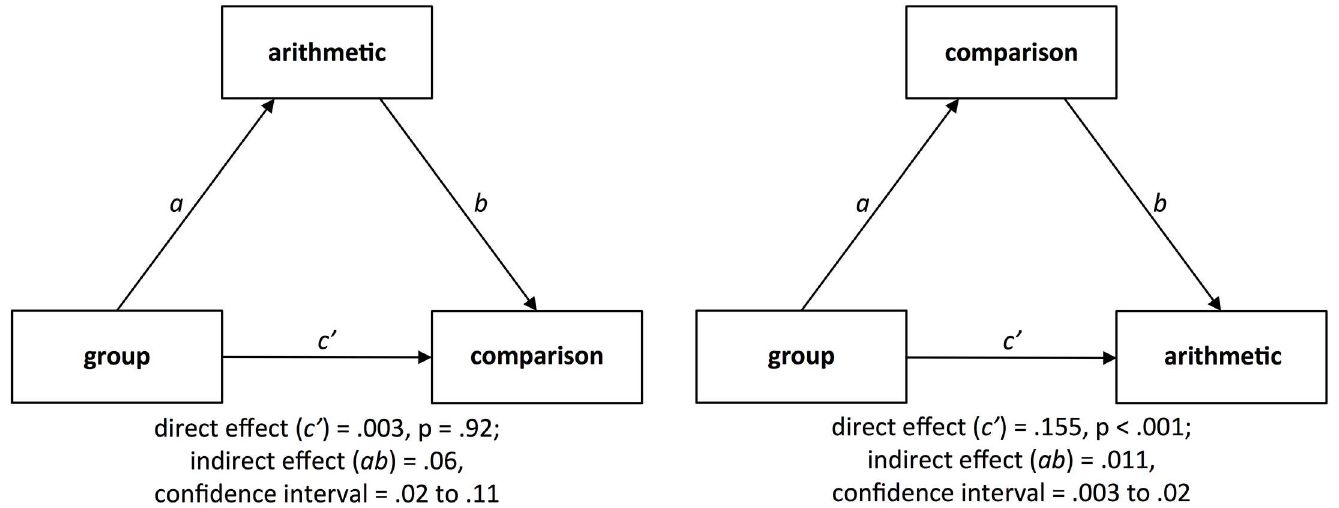
Fig 2. Mediation models. Left panel: Model testing whetherlog-transformed responsetimes in the arithmetic tasks mediatethe associationbetweenthe factor group (Chinesevs. German) and log-transformed RT in the non-symbolic numerical magnitudecomparisontask. Right panel: Model testing whetherlog-transformed RT in the non-symbolic numerical magnitude comparisontask mediate the associationbetweenthe factor group (Chinesevs. German) and log-transformed responsetimes in the arithmetic tasks.